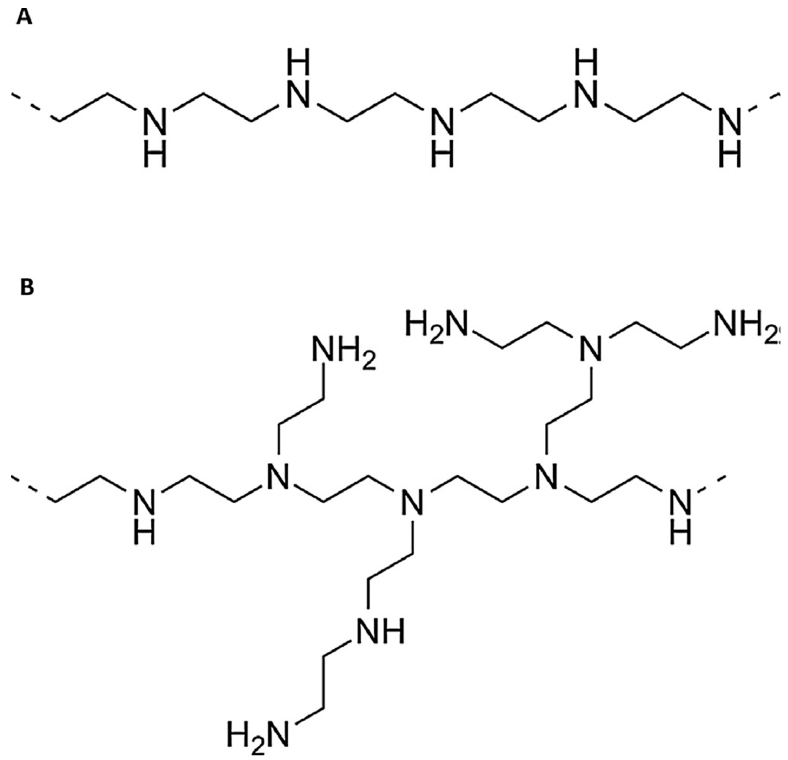
Figure 3. Chemical structures of linear ( A ) and branched ( B ) polyethyleneimine.